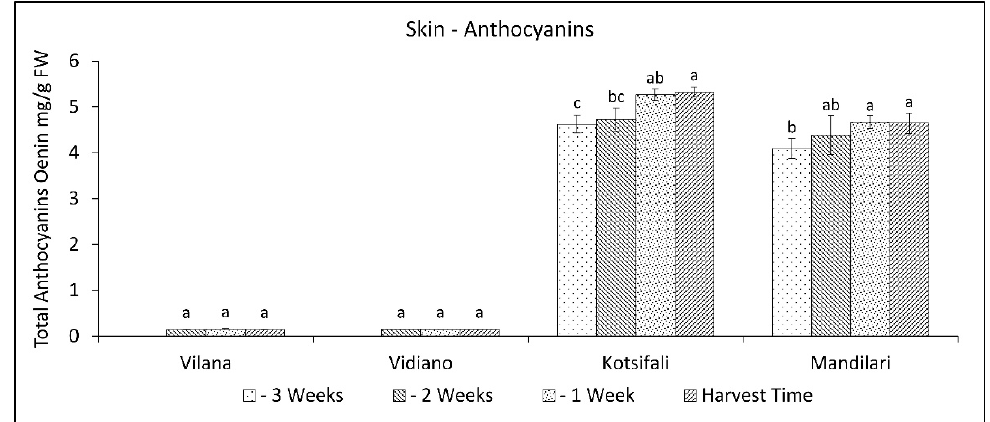
Figure 4. Skin anthocyanins content of Vilana, Vidiano, Kotsifali and Mandilari cultivars during ripening. The error bars represent the standard errors of the means. Different letters indicate statistically significant differences among weeks, according to Duncan’s multiple range test ( p ≤ 0.05).